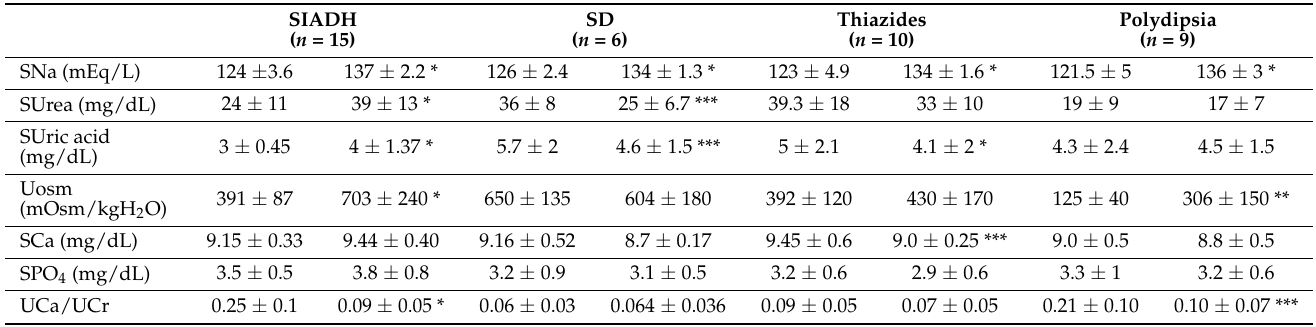
Table 2. Evolution of UCa/UCr ratio before and after correction of SNa (mean ± SD).